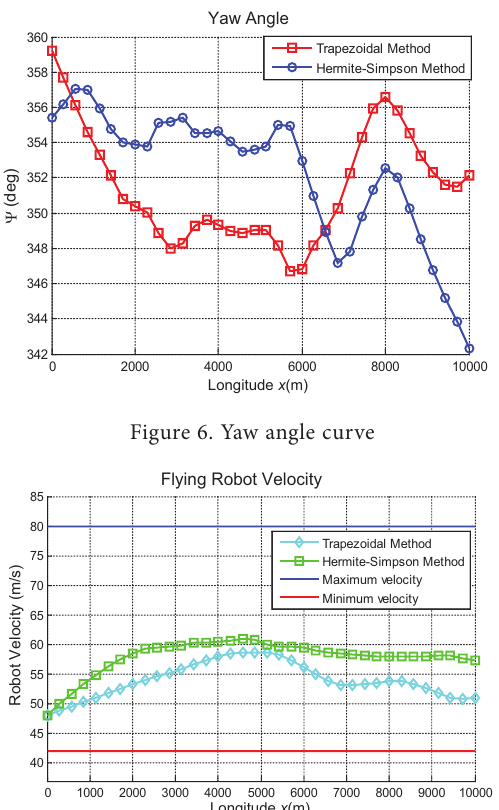
Figure 3. Simplified view of the terrain with trajectory